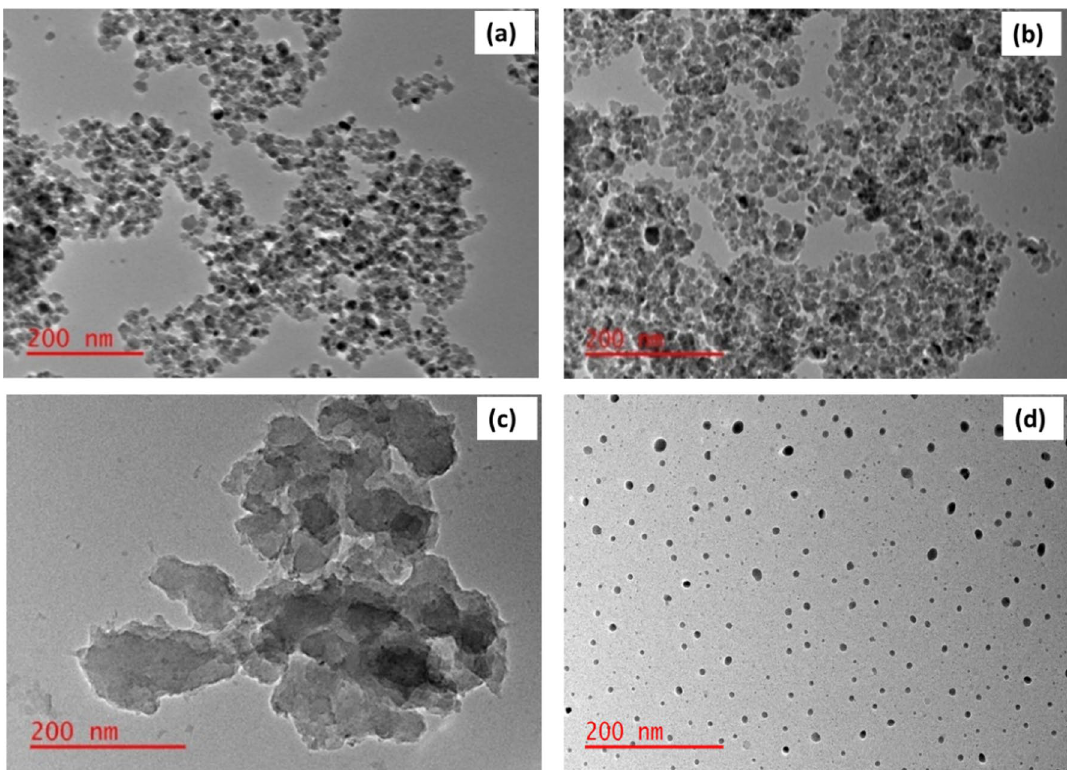
Figure 3. TEM micrograph of ( a ) Biomag-CMC, ( b ) MagNPs-CMC, ( c ) BioMag and ( d ) MagNPs.